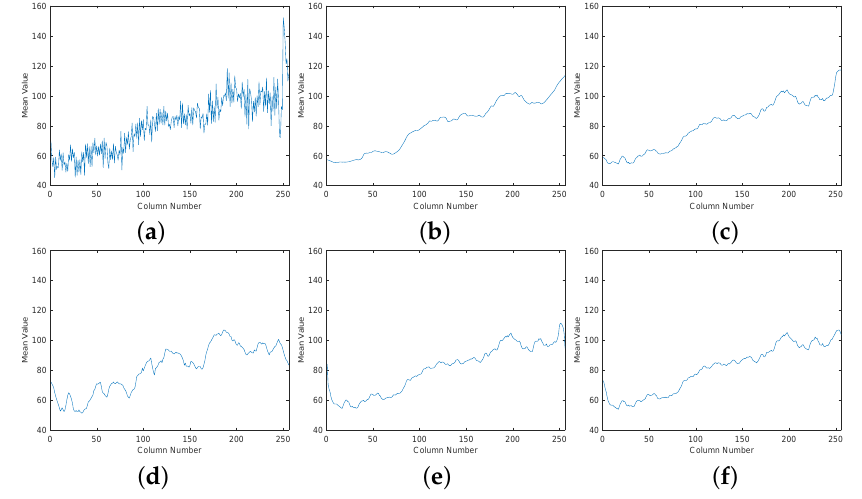
Figure 16. Mean cross-track profiles of Figure 9. ( a ) Original image; ( b ) WAFT; ( c ) SLD; ( d ) GSLV; ( e ) LRSID; ( f ) the proposed